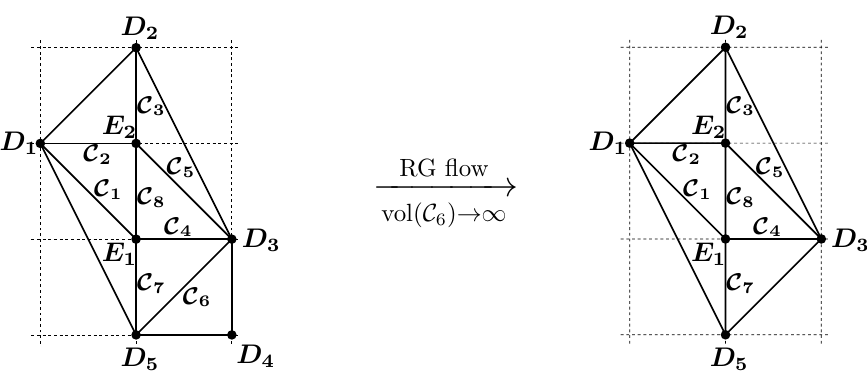
Figure 24 . Decoupling the divisor D 4 leads to a crepant resolution of the E 12 ; 0 singularity.